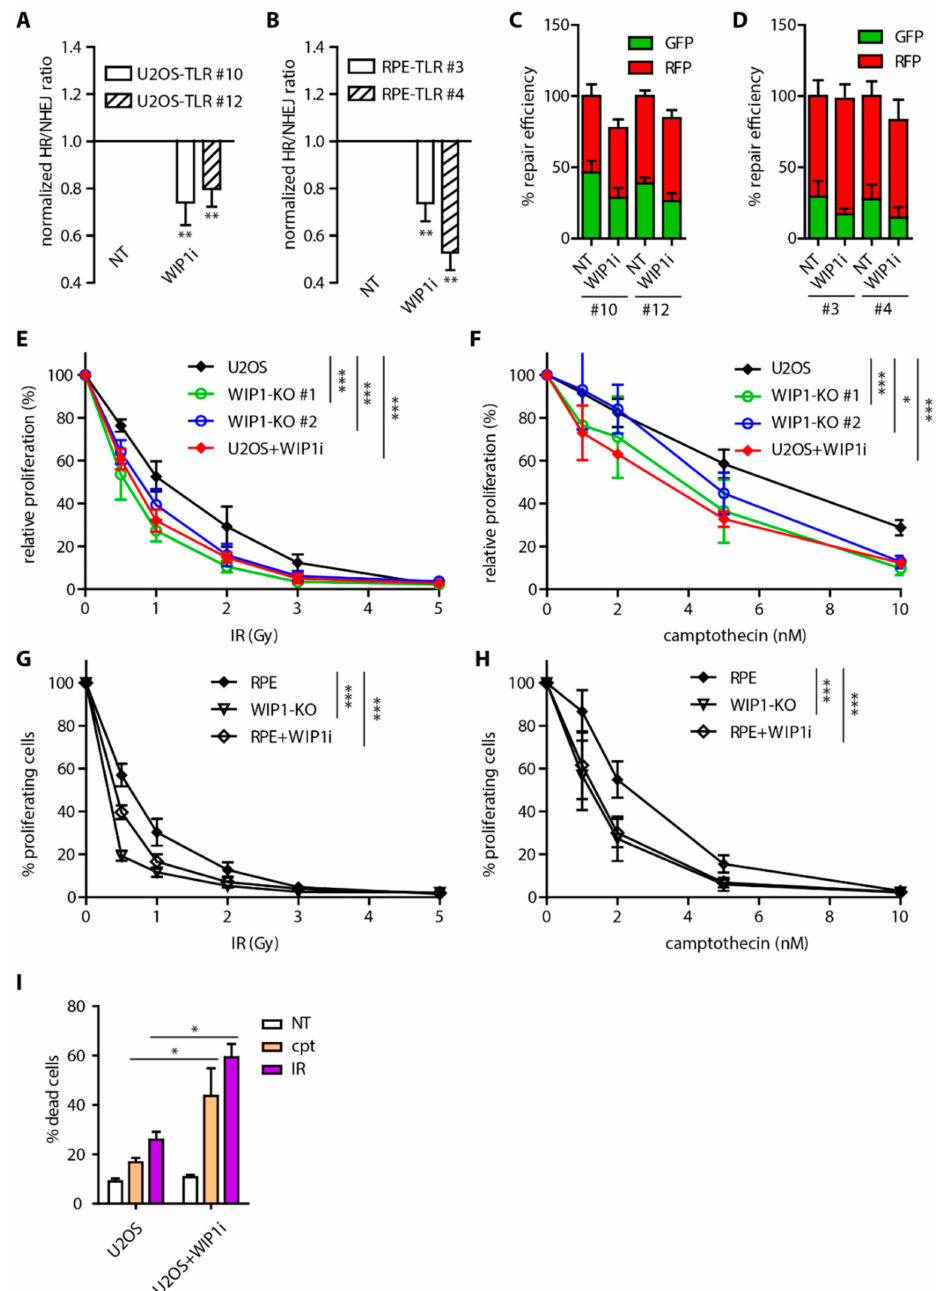
Figure 1. Inhibition of WIP1 impairs homologous recombination (HR). ( A ) Tra ffi c light reporter assay in U2OS cells. Two independent stable cell lines (clones #10 and #12) were transfected with ISceI together with BFP-donor vector with or without pretreatment with 1 µ M WIP1i. E ffi ciency of repair was analyzed 3 days after transfection by FACS. Plotted is mean of normalized ratio of GFP + / RFP +